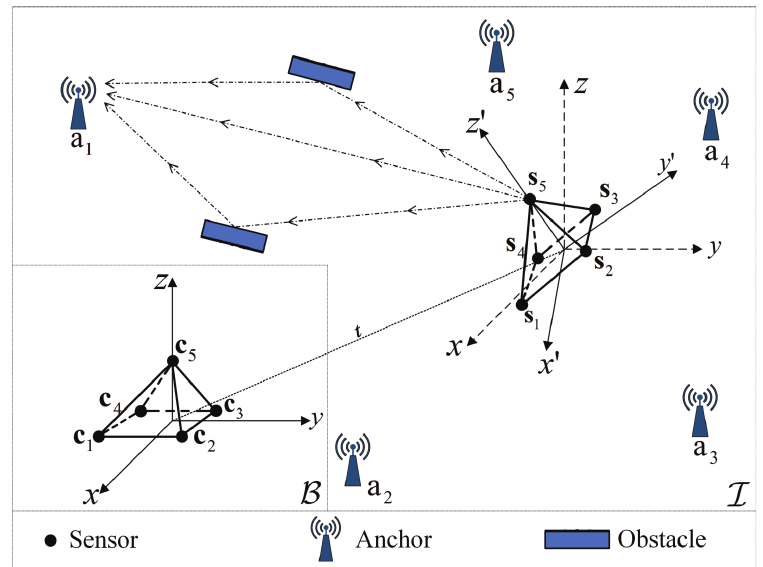
Figure 1. 3–D scenario of rigid body localization in the NLOS